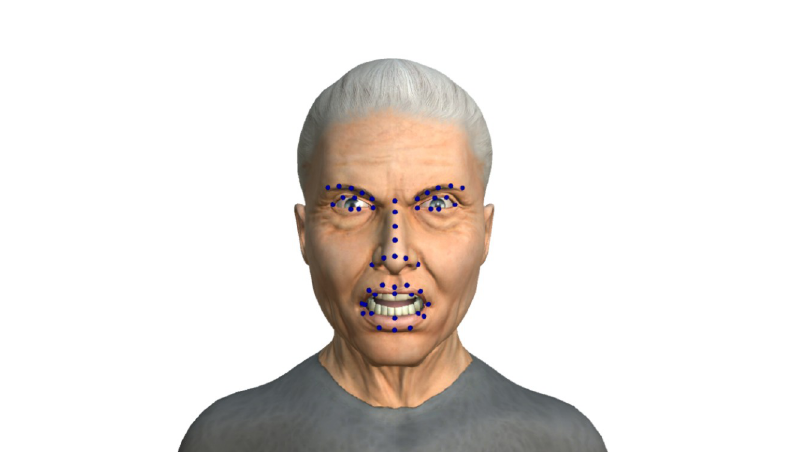
Fig 5. Enraged Shouting expression with